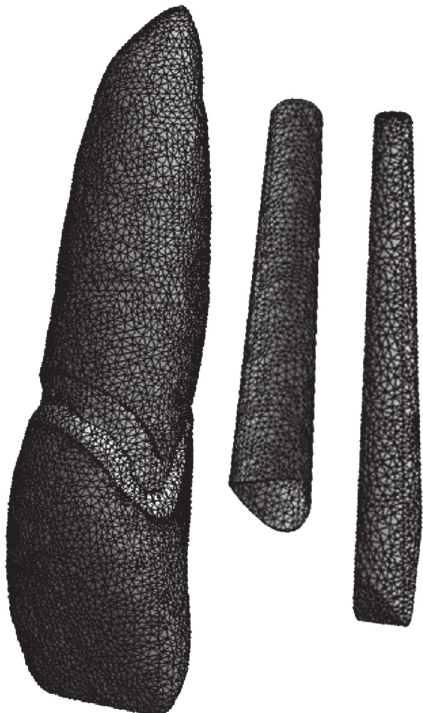
Table 1- Mechanical properties of the materials, elastic modulus (E) and Poisson ratio